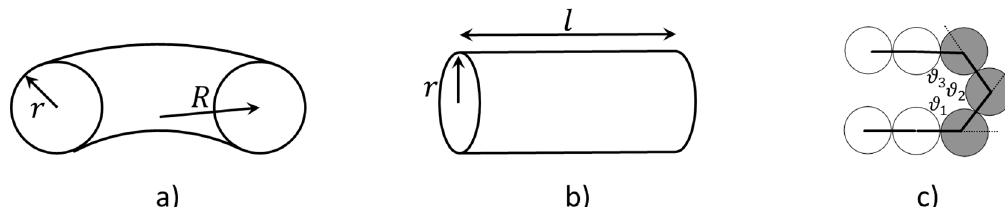
Figure 2. Schematics of torus ( a ) and bundle ( b ); ( c ) Schematic of a generic end fold we consider in this work, which has three exposed monomers (colored in gray). The angles in the end fold, ϑ 1 ´ 3 , are formed among three consecutive monomer beads. For simplicity, these angles are taken to be 120 ° .